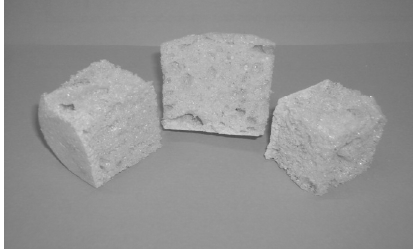
Figure 5b. SEM micrographs of modified epoxy foams.